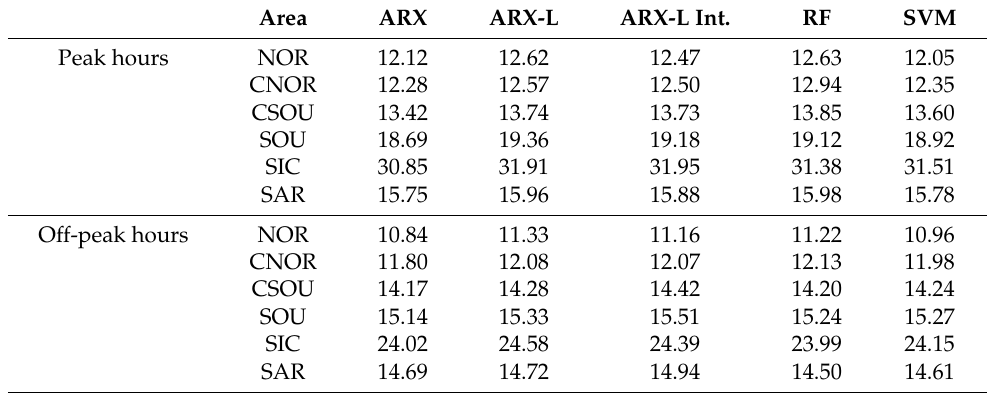
Table 3. Mean value of RMSPE over peak (14 h) and off-peak (10 h) hours. Values are obtained as the percentage ratio of RMSE to the average price observed over the prediction horizon in the same hour group (peak and off-peak).